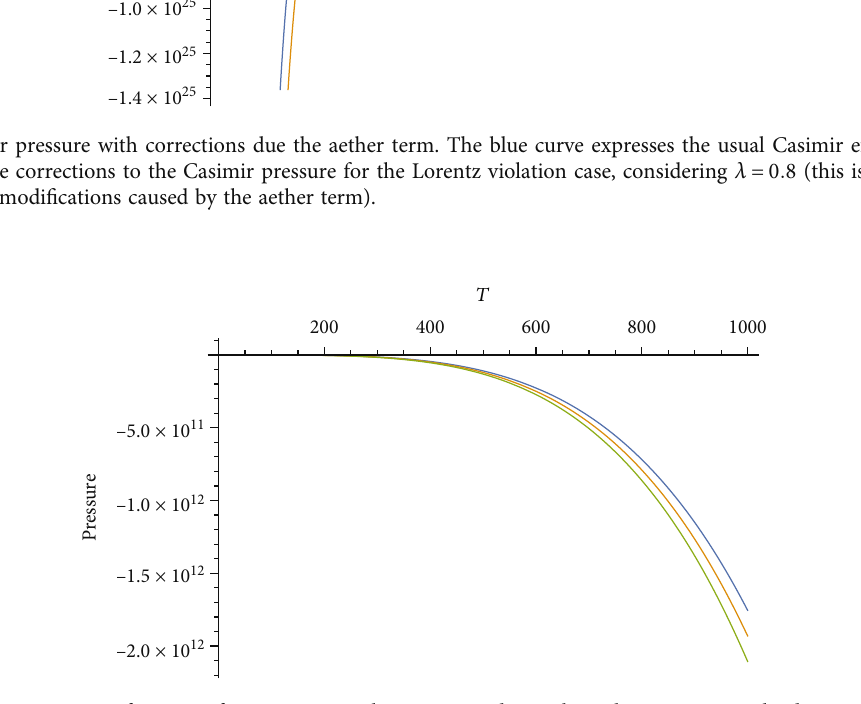
Figure 3: The Casimir pressure as a function of temperature with corrections due to the aether term. Here, the distance between the plates d is taken as d = 10 − 6 m. The blue curve displays the Lorentz invariant phenomenon with λ = 0 ; the yellow and green curves show the corrections due to the aether term for the cases λ = 0 : 1 and λ = 0 : 2 , respectively.